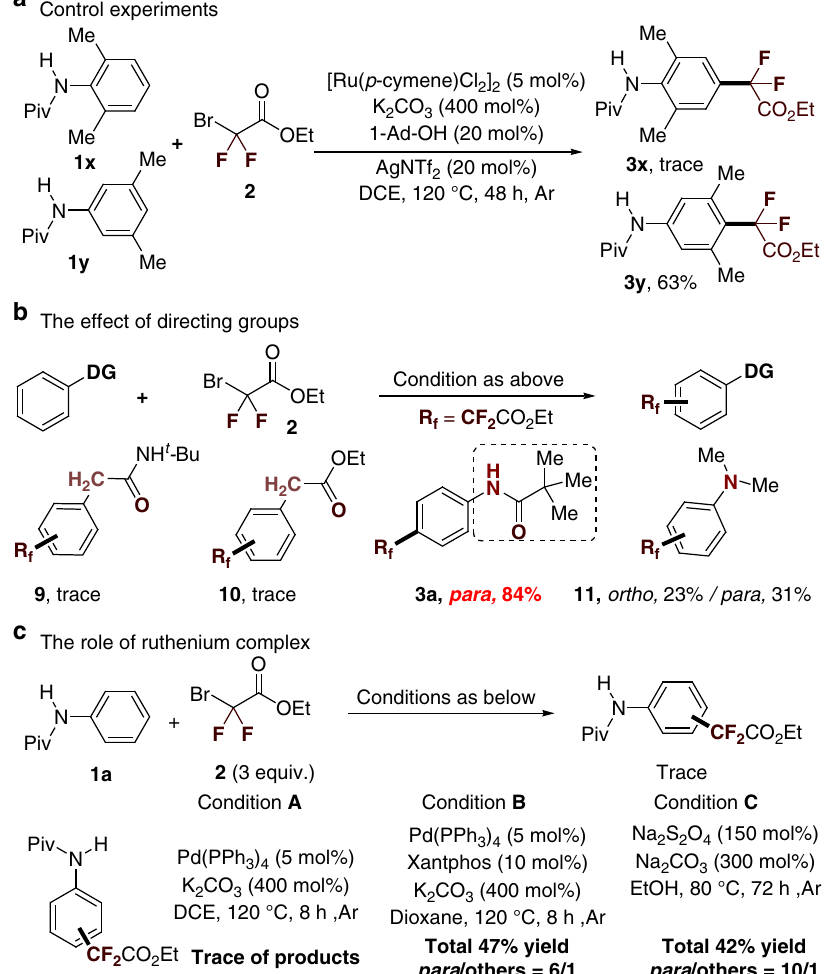
Fig. 5 Preliminary studies on the mechanism. a Control experiments. b The effect of directing group. c The role of ruthenium